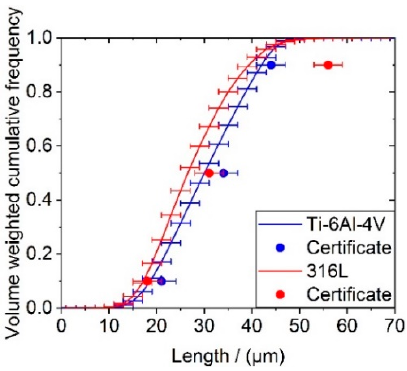
Figure 5. Volume weighted cumulative frequency for Ti–6Al–4V (blue) and 316L ( red ) based on CT analysis in comparison with the certificated values for D 10 , D 50 , and D 90 ( filled circles ) Table 1. Comparison of volume-weighted powder particle size distributions obtained by laser diffraction (LD) and by CT.